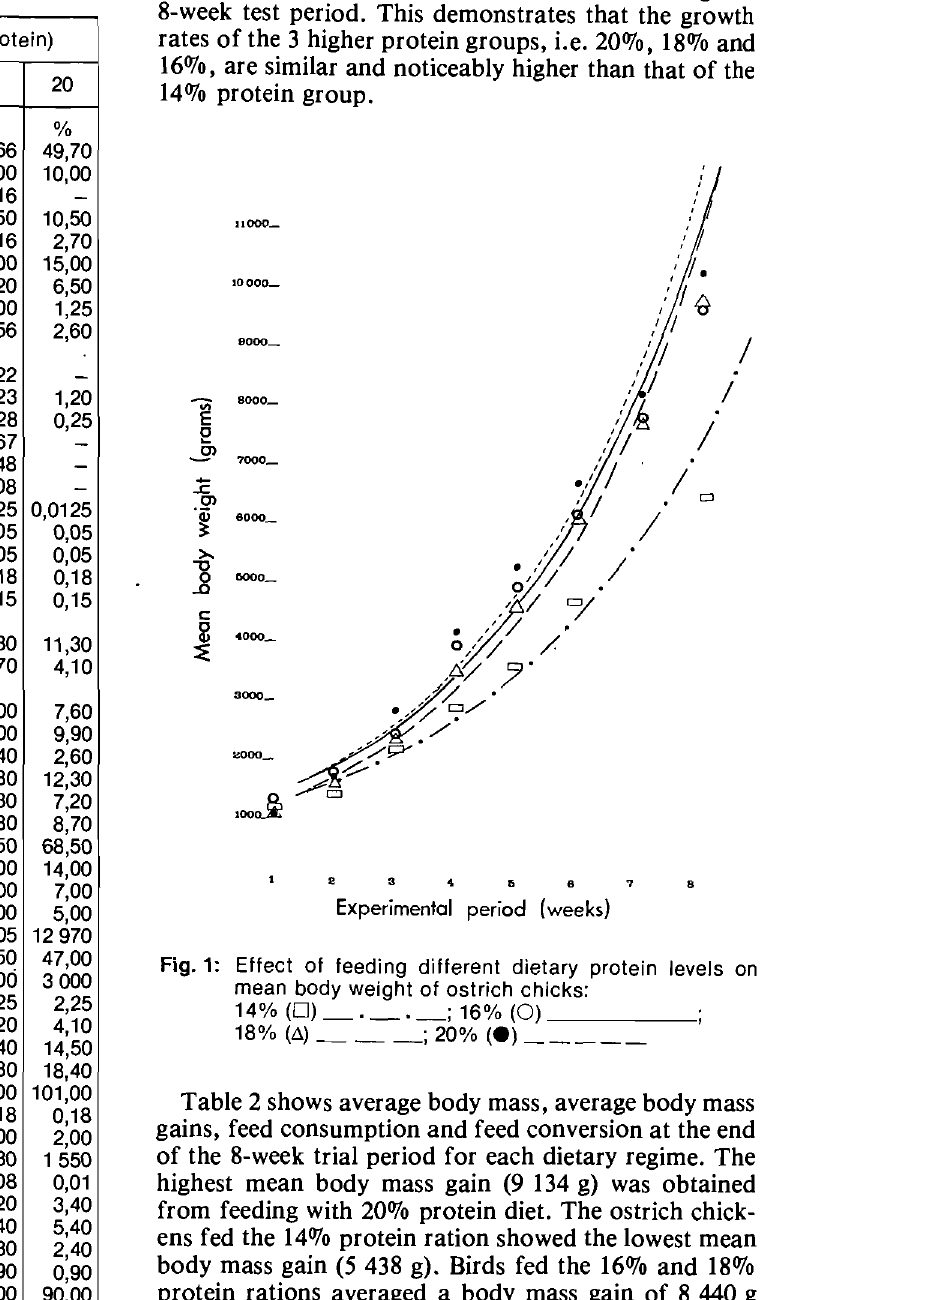
Fig. 1: Effect of feeding different dietary protein levels on mean body weight of ostrich chicks: 14% (0)_._._; 16% (0) ____ _ 18% (~) ___ ; 20% (e) ____